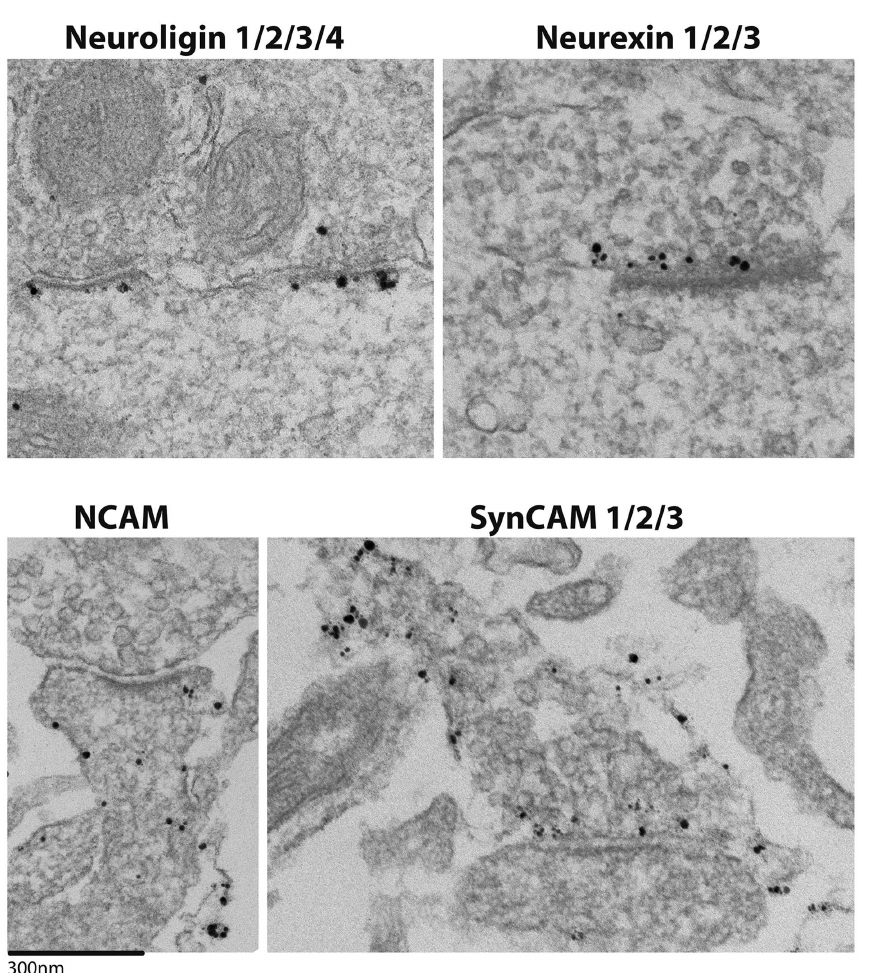
Fig 6. Localization of cell adhesion molecules by immuno-electron microscopy. Electron micrographs show synapticregions from perfusedmouse brain (top left image only) and cultured rat hippocampal neurons. Neuroligin and neurexinlabelingis exclusive to the synaptic region, showingpostsynaptic and presynaptic preferences respectively.Whereas, NCAM and SynCAM show a broaderdistribution within the neuron, with preferentiallabelingat dendriticand axonal plasma membranes,